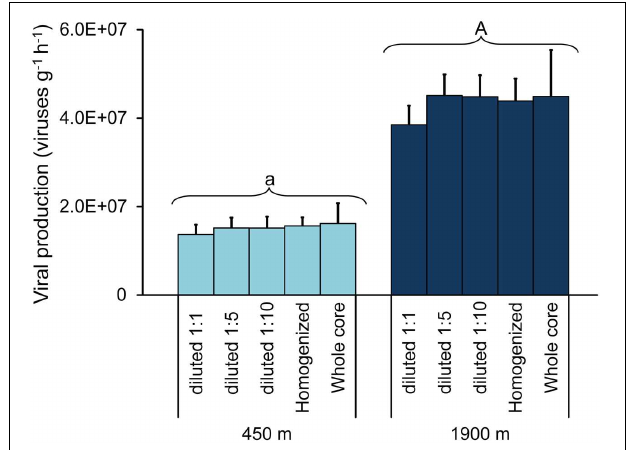
FIGURE 2 | Viral production rates obtained on diluted sediments (1:1, 1:5, and 1:10 times); homogenized and undiluted sediments and intact sediment cores collected at 450 m (light blue bars) and at 1900 m water depth (dark blue bars). Mean values ( n = 3) and SDs are reported. The upper case letter “A” for the station at 1900 m indicates values significantly higher ( p < 0.01) than at 450 m water depth (marked with lower case letter